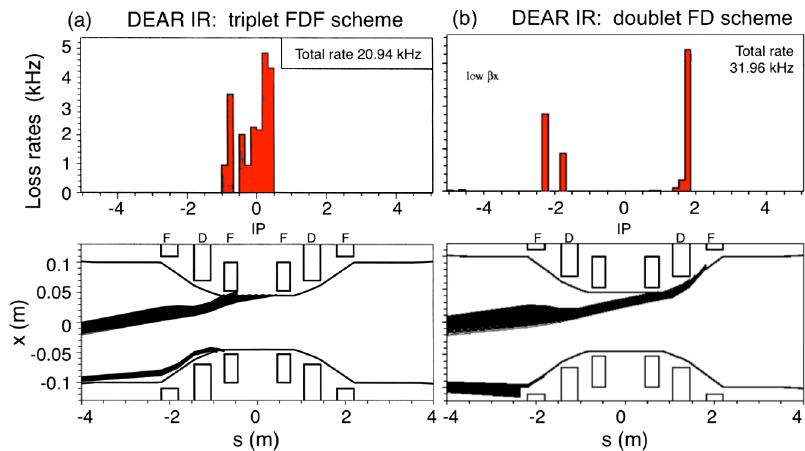
FIG. 10. Upper and lower plots show distribution and trajectories of Touschek particles lost at the DEAR IR for the two low- (cid:6) configurations: (a) focusing-defocusing-focusing quadrupoles, for which the lowest (cid:6) x value at IP is 4 m; (b) focusing-defocusing quadrupoles, for which the lowest (cid:6) x value at IP is 1.5 m.